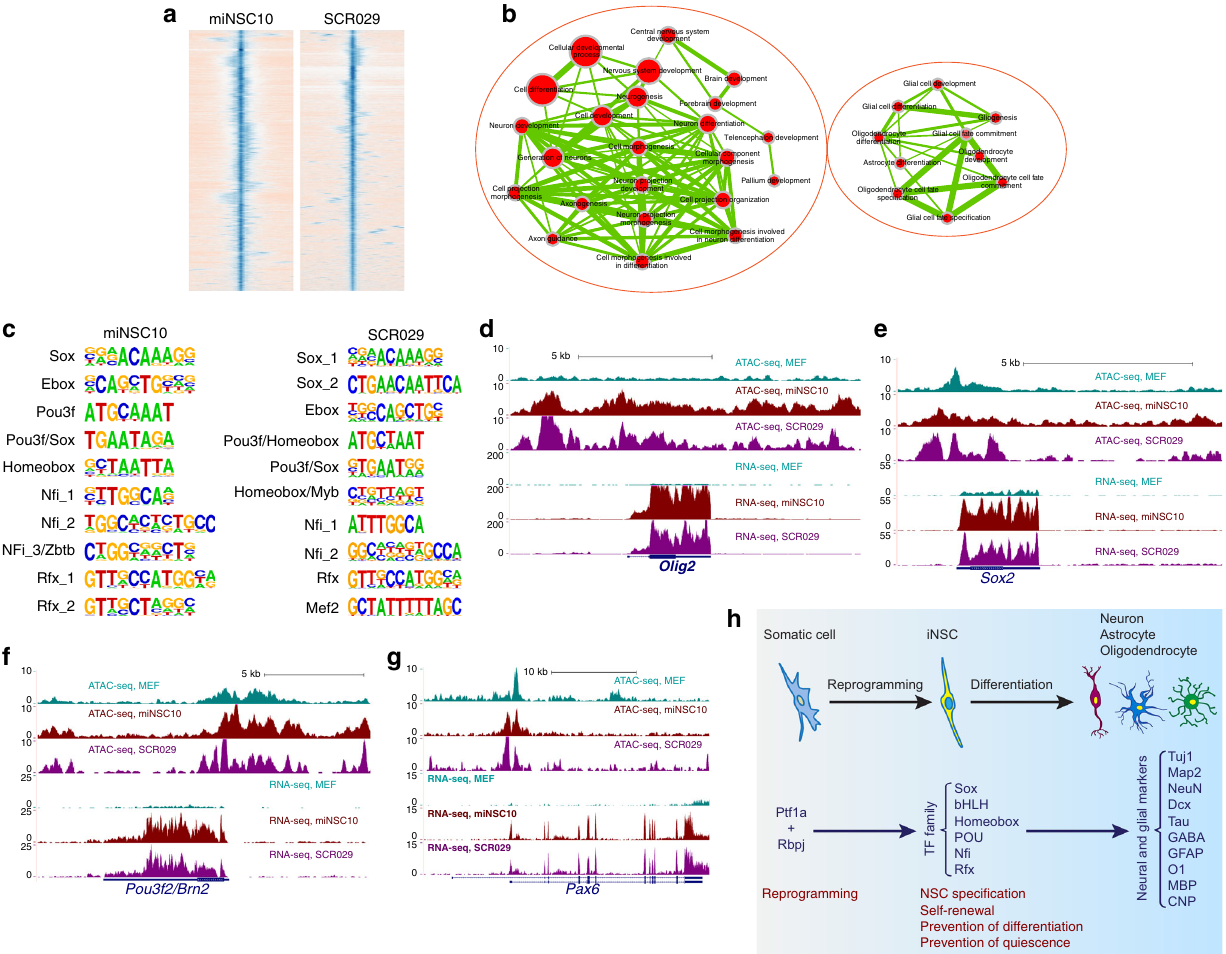
Fig. 8 Genome-wide analysis of chromatin accessibility and gene expression in iNSCs and NSCs. a Heatmaps of ATAC-seq signals for miNSC10 and SCR029 cells within an 8 kb window centered around the peak summit. b Gene ontology (GO) enrichment analysis of the genes associated with miNSC10 ATAC-seq peaks. They were analyzed for GO term enrichment by BiNGO and the result was visualized on a network of gene sets (nodes) connected by their similarity (edges). Node size represents the gene-set size and edge thickness represents the degree of overlap between two gene sets. Depicted are two prominent groups of enriched gene sets. c The 10 top-ranked TF-binding motifs for both miNSC10 and SCR029 cells identi fi ed by de novo motif search in a 300-bp window centered at the peak summit. d – g Genome browser view of ATAC-seq and RNA-seq signals at the Olig2 , Sox2 , Pou3f2 , and Pax6 loci in MEF, miNSC10, and SCR029 cells. The y axis represents the number of normalized reads. h Schematic showing the process by which Ptf1a directly reprograms somatic cells into tripotent iNSCs and the associated molecular changes. Ptf1a must form DNA-binding complex with Rbpj to directly or indirectly activate expression of several families (Sox, bHLH, homeobox, POU, N fi , and Rfx) of transcription factor genes involved in NSC self-renewal